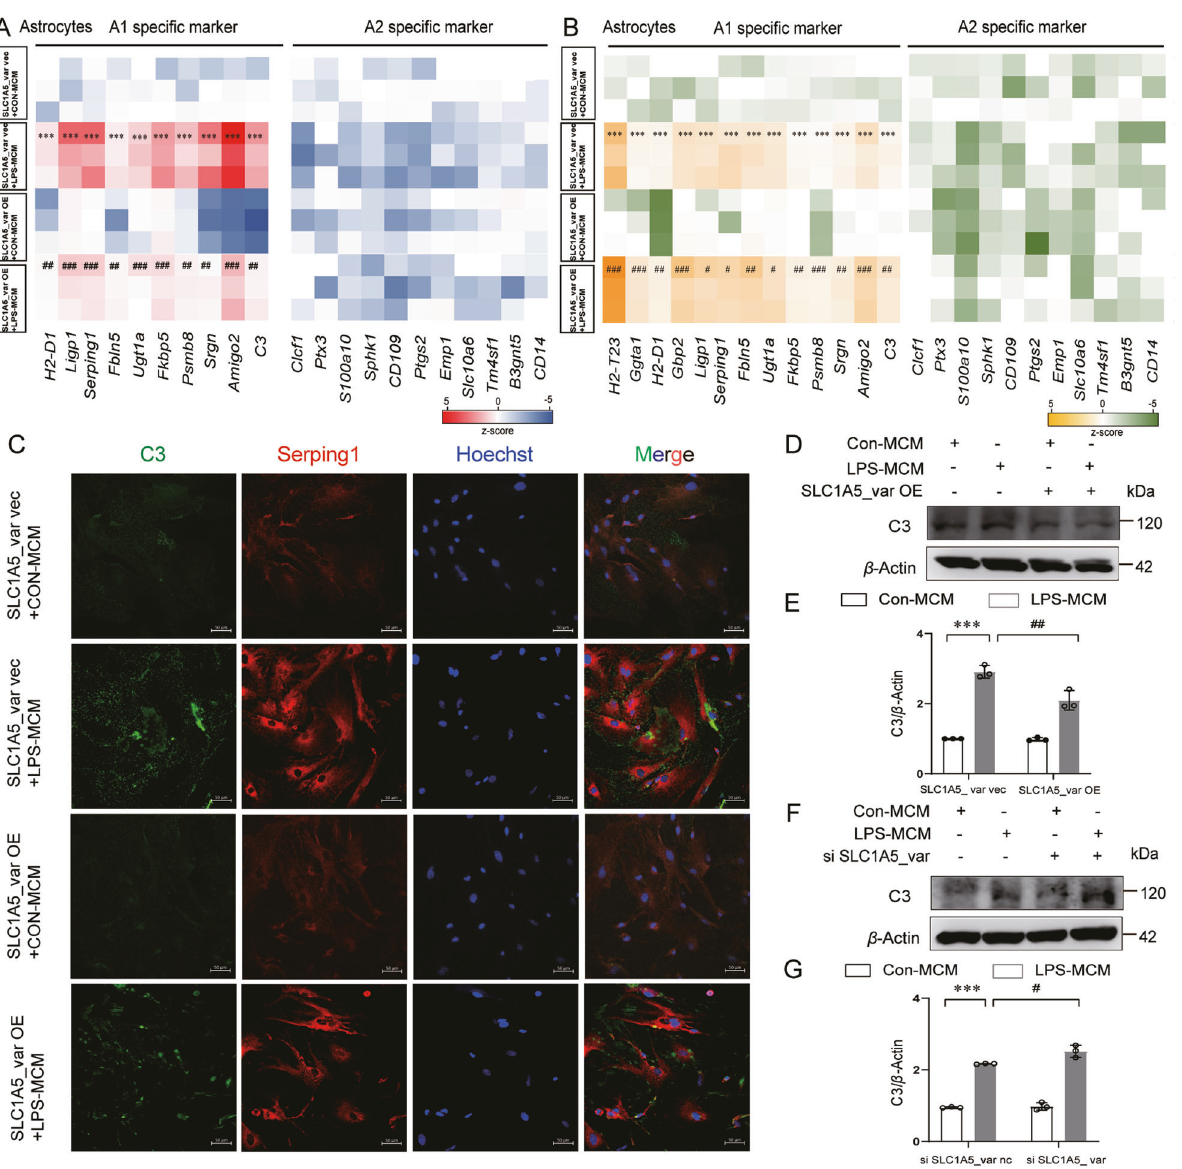
PCR. Heatmap of A1-speci fi c and A2-speci fi c markers in astrocytes while SLC1A5var was overexpression ( A ) ( n = 3) or knockdown ( B ) ( n = 3). C Colocalization of C3 (green) and Serping1(red) while SLC1A5_var was overexpressed. Scale bar, 50 μ m. Expression of C3 was determined by Western blot while SLC1A5_var was overexpression ( D ) or knockdown ( F ) and quanti fi ed by densitometry ( E , G ) ( n = 3). Data are shown as the mean ± S.E.M. *** P < 0.001 vs control, # P < 0.05, ## P < 0.01 vs LPS group , two-way ANOVA followed by Tukey ’ s post hoc